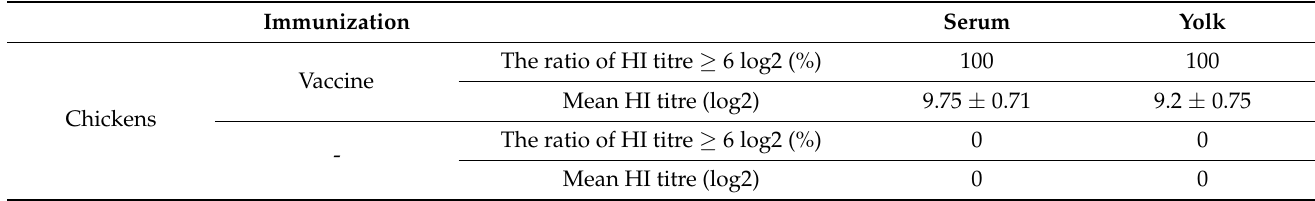
Table 6. The titres of egg yolk antibody at 3 weeks after